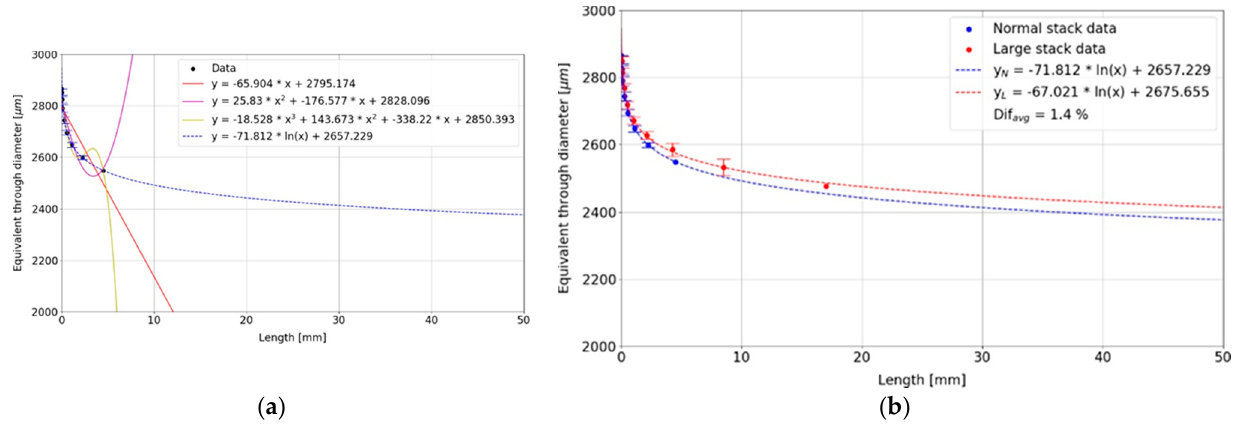
Figure 9. Prediction of D eq for the D nom = 3 mm channel. The length value on the x-axes corresponds to the length of a straight channel segment of which the equivalent diameter may be predicted. ( a ) Testing of the appropriate fitting; ( b ) normal stack size vs. large stack size.